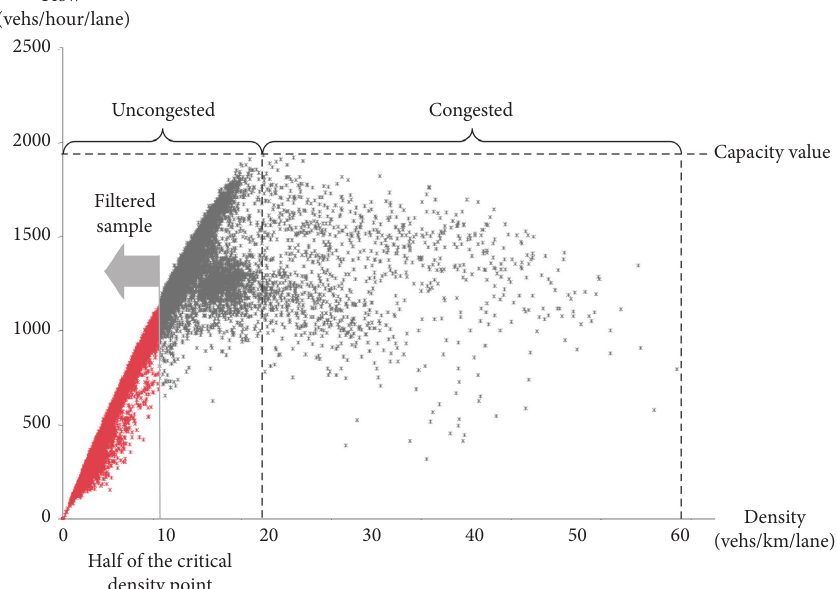
Figure 3: Fundamental diagram of a loop detector at a study